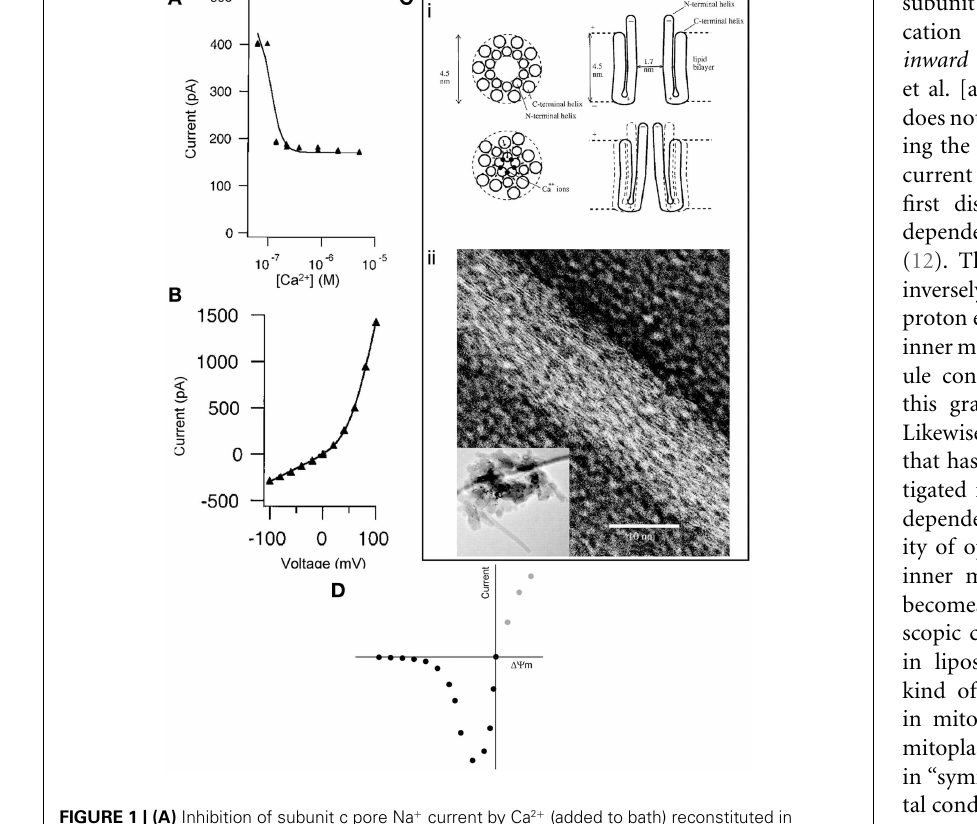
FIGURE 1 | (A) Inhibition of subunit c pore Na + current by Ca 2 + (added to bath) reconstituted in liposomes. Conditions: 60mV, ionic strength = 0.06M, [Na + ] = 50mM, [Mg 2 + ] = 15mM. (B) Current-voltage plot of subunit c pore current as constant ionic strength of 0.2M. Both panels were reproduced from McGeoch et al. (7) by permission from Elsevier. (C) (i) Concept for the Ca 2 + control of the mammalian subunit c pore conductance. Reproduced from McGeoch et al. (7) by permission from Elsevier. (ii)Transmission electron microscopy (inverted image) of a tube whose surface is covered by strands of subunit c with a lateral spacing of 3.7Å amidst circular structures that could be assembled channels of subunit c of 3 nm diameter.The inset image shows a lower magnification of the entire pile of collapsed tubes on the grid and in their center are crystals. Reproduced from McGeoch and McGeoch (10) (free via Creative Commons). (D) Hypothetical current-voltage plot of the PTP during patch-clamp in symmetrical solution. Intersect is at 0mV,